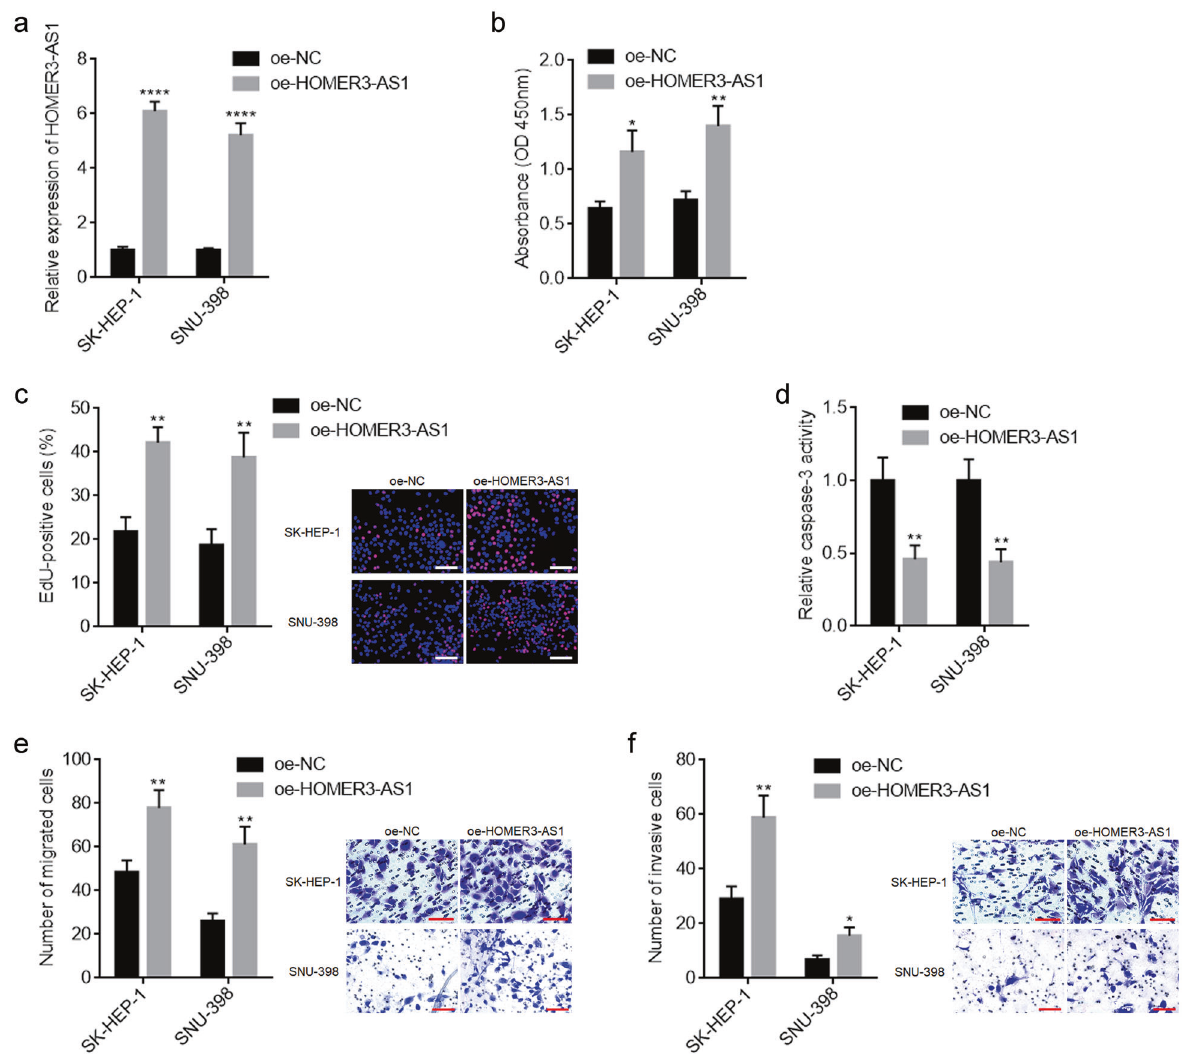
Fig. 2 Overexpression of HOMER3-AS1 promoted HCC cellular malignant phenotype. a HOMER3-AS1 expression in SK-HEP-1 and SNU-398 cells with HOMER3-AS1 stable overexpression was measured by qRT-PCR. b Cell proliferation of SK-HEP-1 and SNU-398 cells with HOMER3-AS1 stable overexpression was determined by CCK-8 experiments. c Cell proliferation of SK-HEP-1 and SNU-398 cells with HOMER3-AS1 stable overexpression was determined by EdU incorporation experiments. Scale bars, 100 µm. The red color indicates EdU-positive nucleuses and blue color indicates all cellular nucleuses. Results are shown as the ratio of EdU-positive nucleuses to all cellular nucleuses. d Cell apoptosis of SK-HEP-1 and SNU-398 cells with HOMER3-AS1 stable overexpression was determined by caspase-3 activity assays. e Cell migration of SK-HEP- 1 and SNU-398 cells with HOMER3-AS1 stable overexpression was determined by transwell migration assays. Scale bars, 100 µm. f Cell invasion of SK-HEP-1 and SNU-398 cells with HOMER3-AS1 stable overexpression was determined by transwell invasion assays. Scale bars, 100 µm. Results are presented as mean ± SD based on three independent experiments. * p < 0.05, ** p < 0.01, **** p < 0.0001 by Student ’ s t